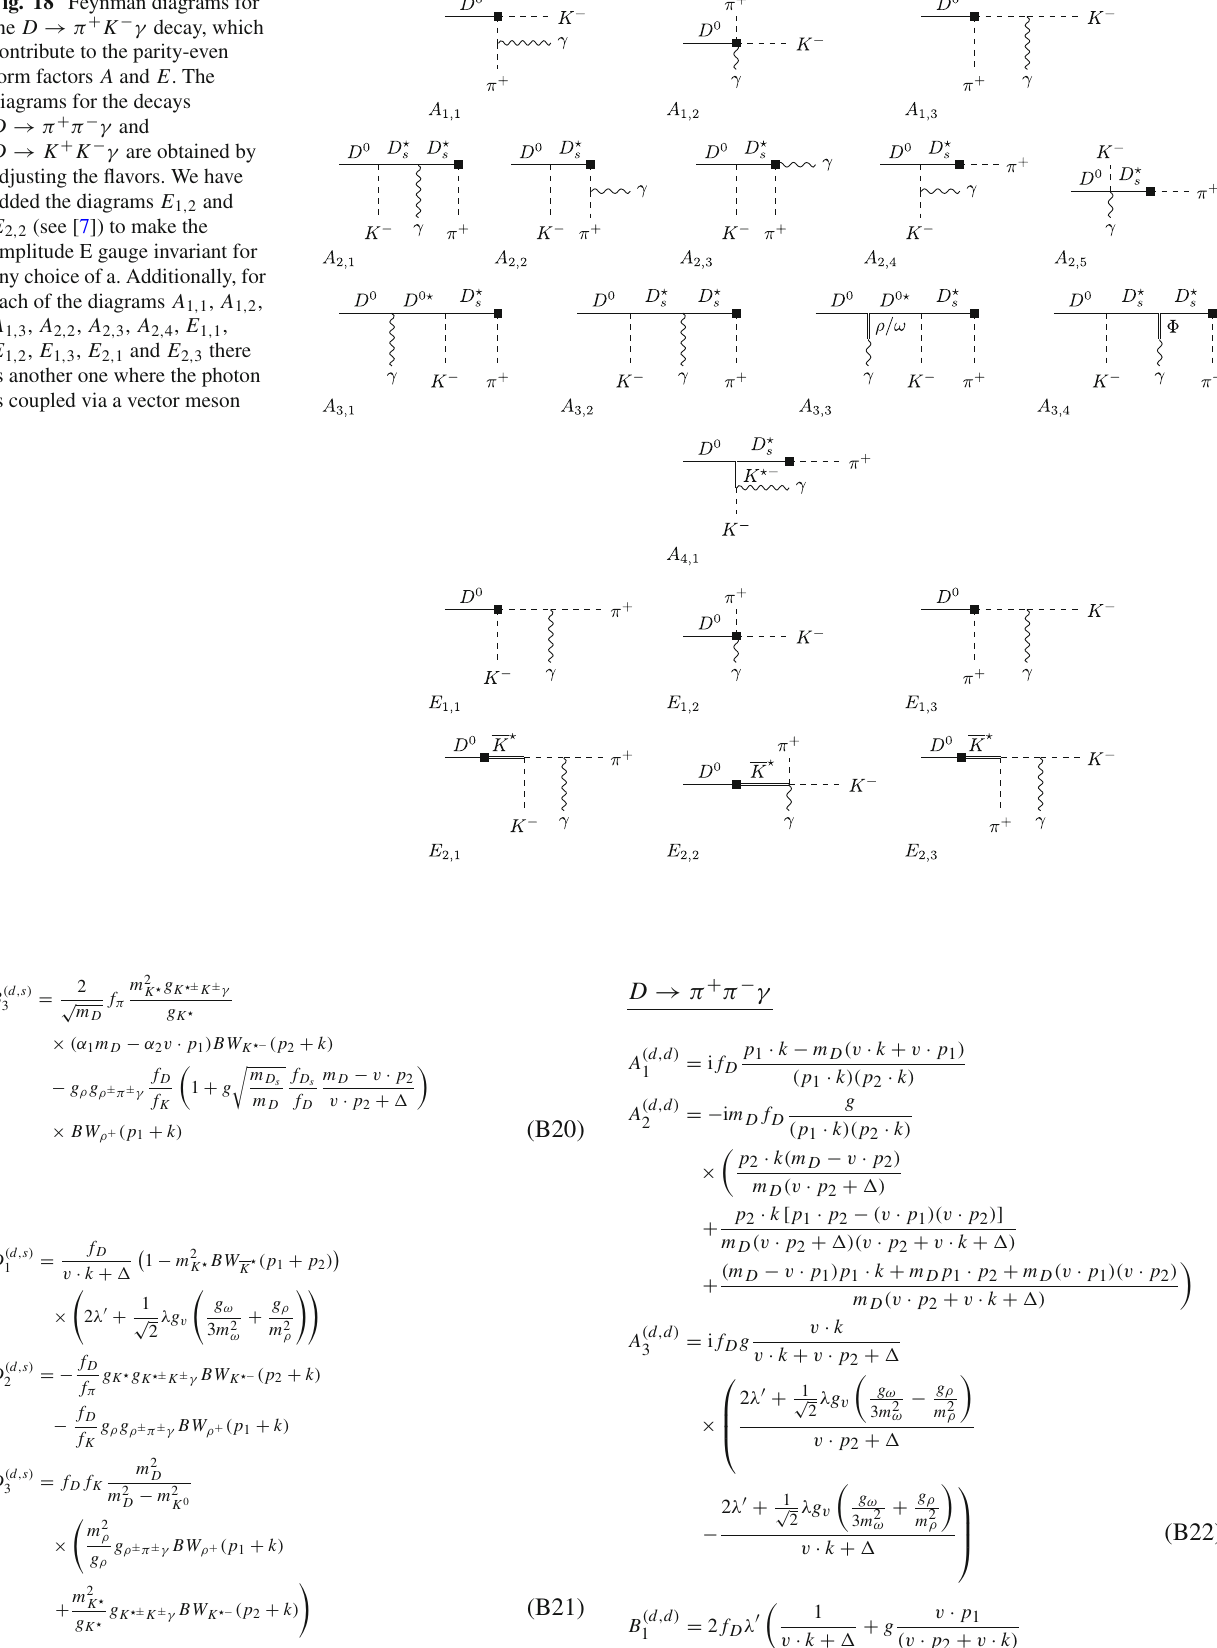
Fig. 18 Feynman diagrams for the D → π + K − γ decay, which contribute to the parity-even form factors A and E . The diagrams for the decays D → π + π − γ and D → K + K − γ are obtained by adjusting the flavors. We have added the diagrams E 1 , 2 and E 2 , 2 (see [7]) to make the amplitude E gauge invariant for any choice of a. Additionally, for each of the diagrams A 1 , 1 , A 1 , 2 , A 1 , 3 , A 2 , 2 , A 2 , 3 , A 2 , 4 , E 1 , 1 , E 1 , 2 , E 1 , 3 , E 2 , 1 and E 2 , 3 there is another one where the photon is coupled via a vector